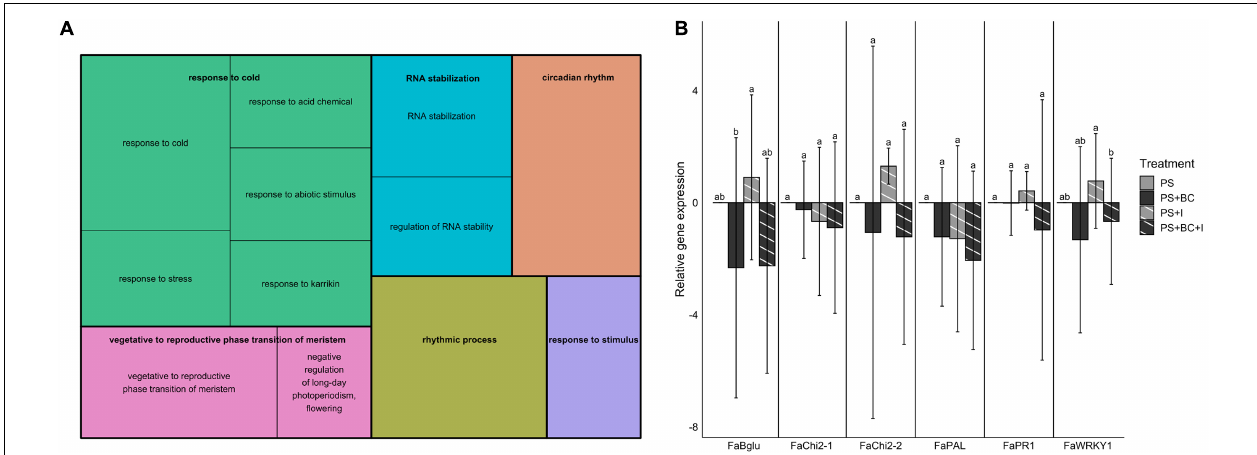
FIGURE 4 | Gene expression in strawberry leaves. (A) Gene ontology (GO) enrichment analysis (biological process) of genes differentially expressed in PS vs. PS + BC + I comparison. The size of the boxes corresponds with the significance of the GO terms. (B) Relative gene expression values (by reverse transcription quantitative PCR) of six defense genes in strawberry for PS and biochar treatments (PS + BC), inoculated with B. cinerea (I) or mock-inoculated. Expression values are expressed in log2 fold changes (mean ± SE). The PS treatment is used as the control treatment; for this treatment, the expression value is set to 0. Statistically significant differences are indicated with different